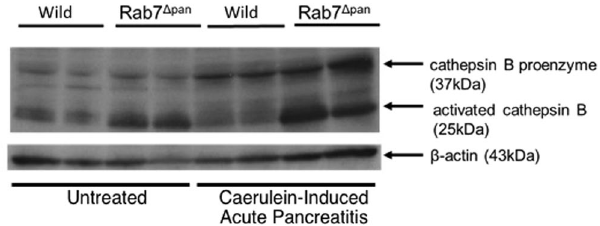
Figure 12. The cathepsin B expression during caerulein-induced acute pancreatitis. WB of cathepsin B using total pancreas homogenates of wild and Rab7 Δ pan mice before (Untreated) and after the induction of acute pancreatitis by caerulein. β -actin was used as an internal loading control. The blots are the representative of two independent experiments with similar